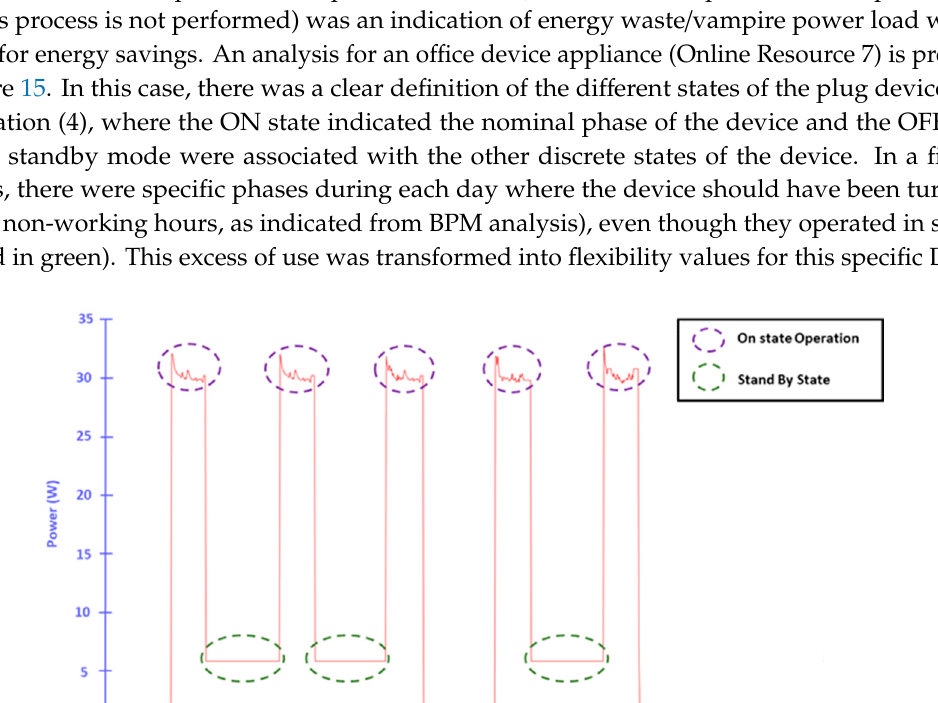
Figure 14. Thermal comfort flexibility.